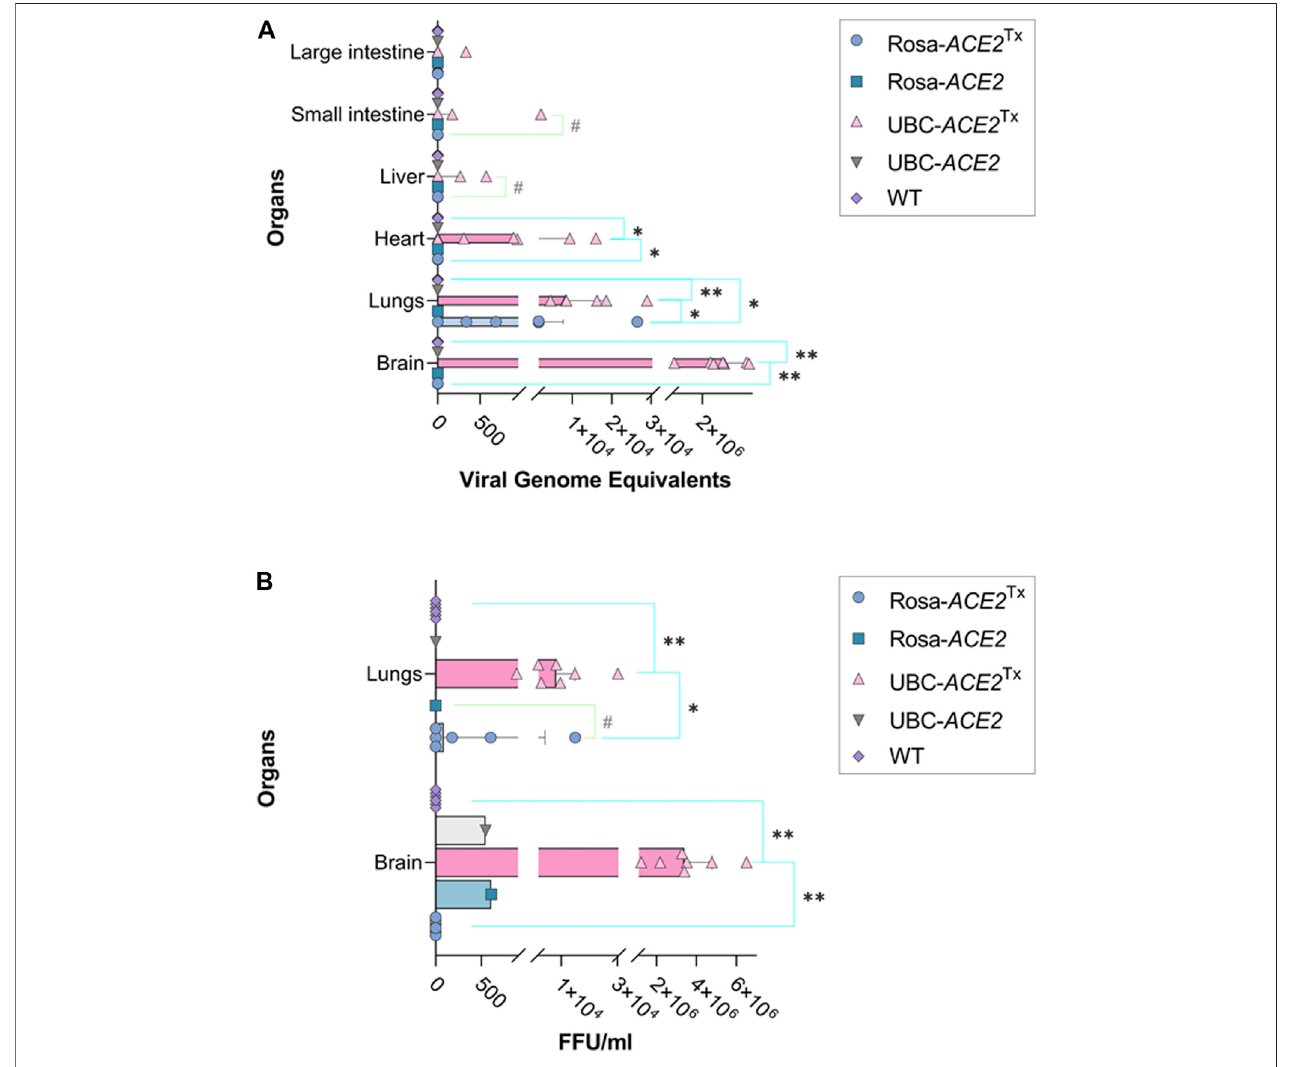
FIGURE 2 | SARS-CoV-2 genome equivalent (A) and focus-forming unit (B) analyses in different samples of mouse organs on the 5th day of infection. (A) Signi fi cantdifferencesbetweenWTandUBC-ACE2 Tx andbetweenRosa-ACE2 Tx inheartandbrain;signi fi cantdifferencesbetweenoverallUBC-ACE2 Tx ,Rosa-ACE2 Tx and WT in lungs. (B) Signi fi cant differences between WT and UBC-ACE2Tx and between Rosa-ACE2 Tx in lungs and brain; Note: * p < 0.05, ** p < 0.001, # p <